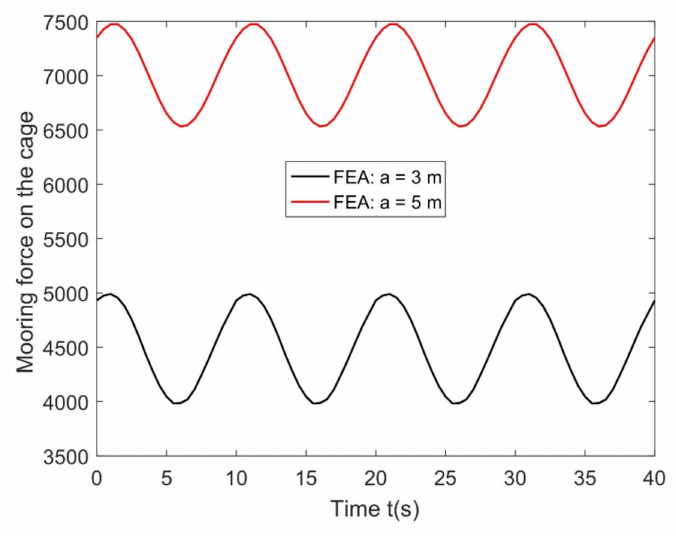
Figure 7. Effects of the cage radius on the mooring force versus time t(s) with a water depth h 1 = 50 m, cage height h 2 = 7 m, and u = 0.5 m/s.